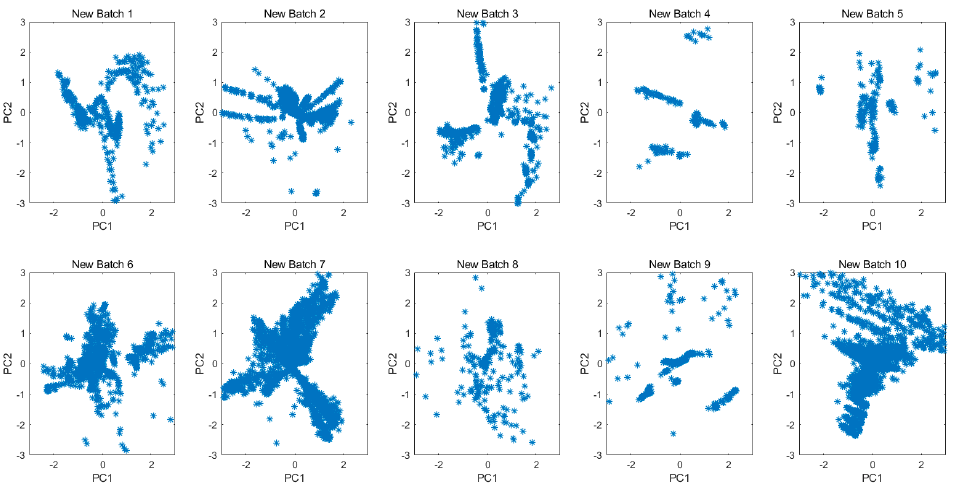
Figure 7. Principal component space of 10 batches for all new data which were transformed from original measurements by the MICF.